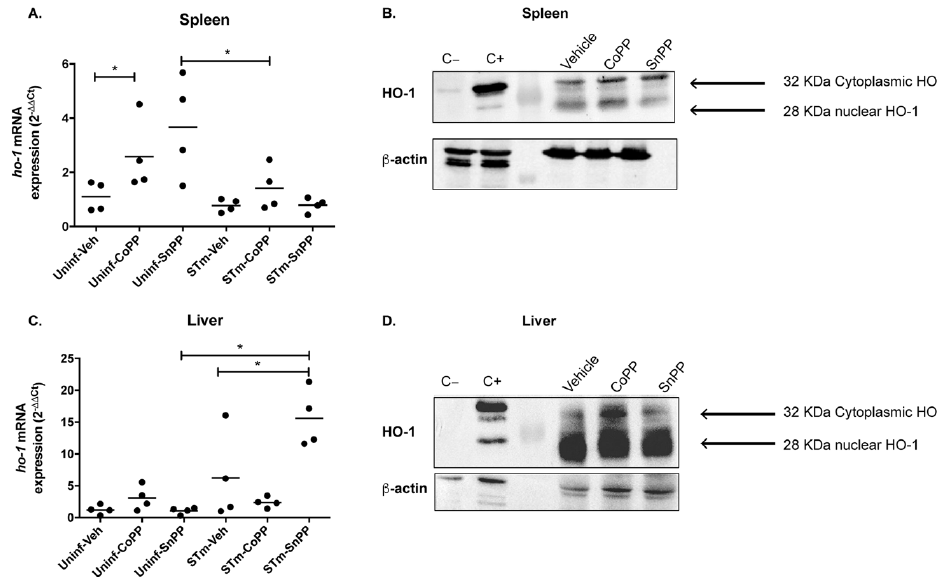
Figure A2. Evaluation of Hmox-1 transcription in tissues of S. Typhimurium-infected mice. Female C57BL/6 mice were treated with CoPP, SnPP or vehicle as uninfected controls. Twenty-four hours later, mice were intragastrically infected with 1 × 10 6 CFUs of S. Typhimurium and on day 6 post- treatment (day 5 post-infection of infected groups), the liver and spleen were recovered to purify RNA or proteins. ( A , C ) Quantitative real time PCR (qPCR) was performed to detect transcription of genes coding for Hmox-1, using the indicated probes in Materials and Methods. As a housekeeping gene, quantification of beta-2-microglobulin mRNA was performed. Data are expressed as fold-in- crease in DDCt. Student’s t -test was used to evaluate differences. Results with statistically signifi- cant differences are shown (*: p < 0.05). ( B , D ). Representative images of Western blot analyses per- formed to assess the production of Hmox-1. Protein preparations from the liver and spleen were performed using RIPA protein extraction buffer and a Western blot assay was performed using anti- Hmox1 and anti- β -actin antibodies. SH-SY5Y cells were treated for 14 h with 10 µM SnPP (negative control) or 10 µM CoPP (positive control). Figure A3. Relative expression of hmox1 in RAW264.7-infected cells treated with Hmox1 modulating drugs. RAW264.7 cells were infected with S. Typhimurium MOI 25 for 1 h, treated with 100 µg/mL gentamicin for 1 h and then treated with either vehicle (0.75 mM NaOH), CoPP 50 µM, SnPP 50 µM for 1 and 4 h.